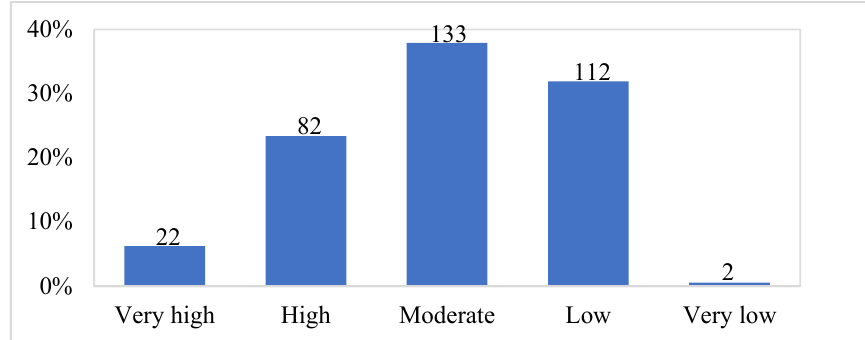
Figure 4. Passengers’ degrees of satisfaction with the sub-ME.